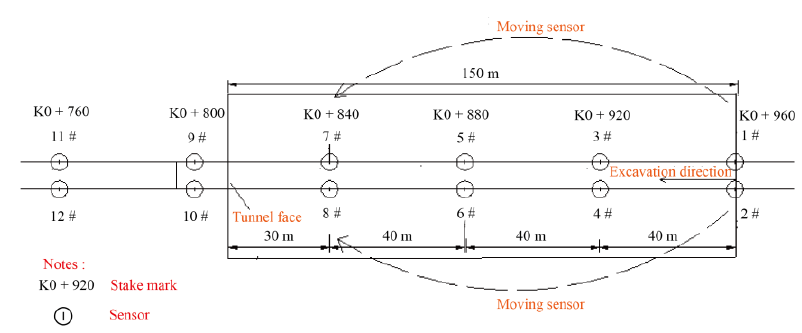
Figure 4. Layout of sensors in the diversion tunnel.